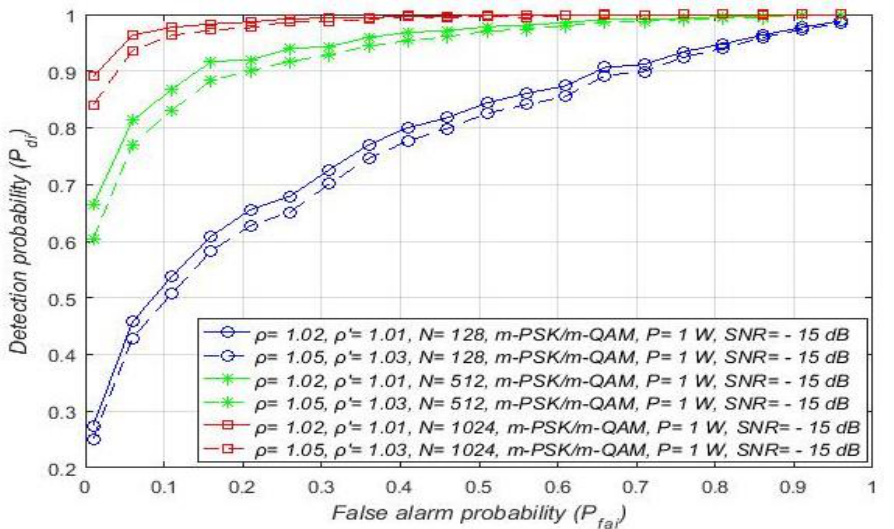
Figure 13. Interdependence between detection and false alarm probabilities for ED of m-PSK/m-QAM modulated signals transmitted with Tx power of 1 W and sensed with the distinct sample quantities.